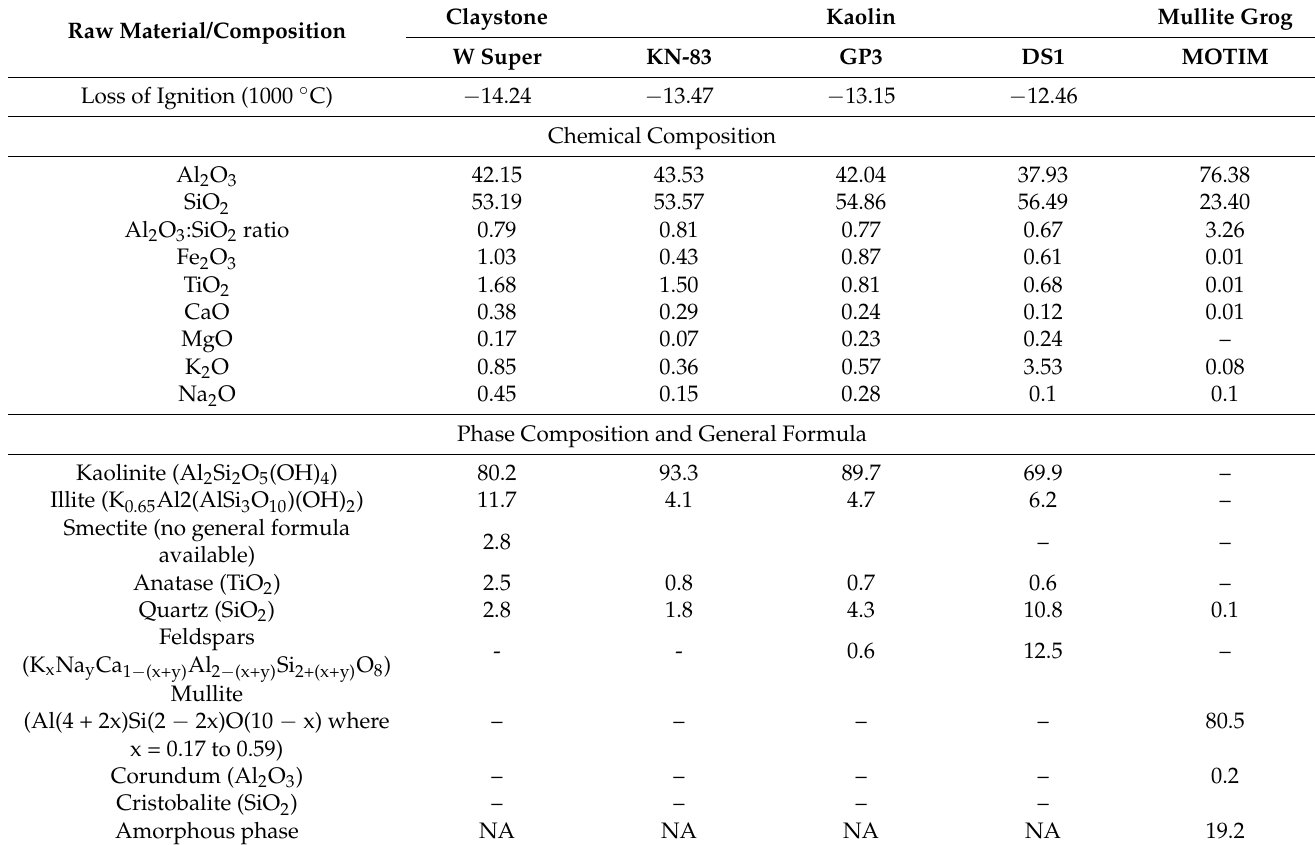
Table 4. Chemical and phase composition of raw materials in wt.%, rounded to two and one decimal places respectively. Raw